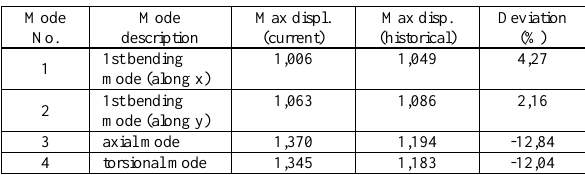
Table 5. Displacements (cm) of the main mode shapes of the